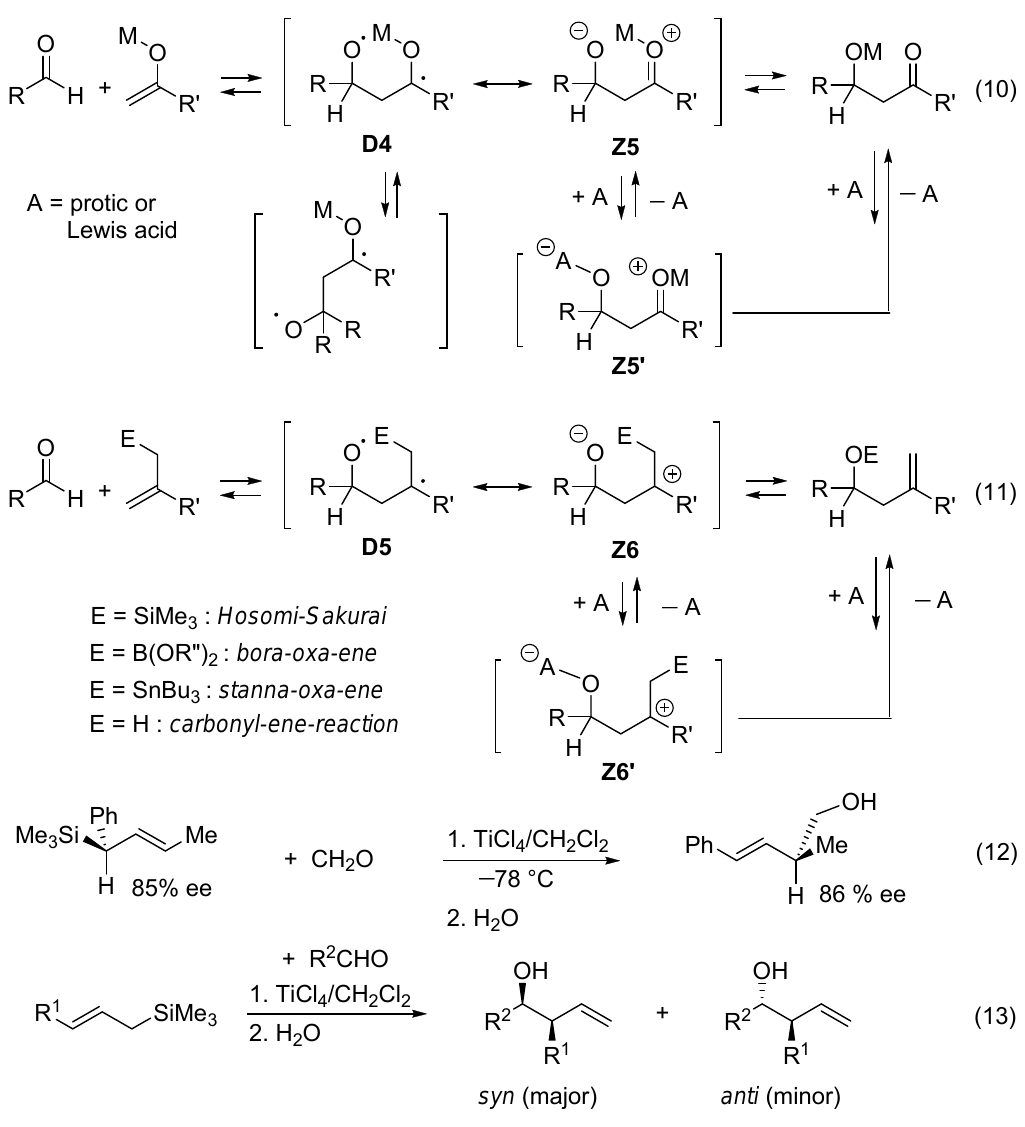
Figure 6. The diradicaloid model illustrated with Equilibria (10) and (11) permits to explain the catalytic effect of added protic or Lewis acids (A) to enolate aldol condensations, to metalla-carbonyl-ene reactions, and the carbonyl-ene-reaction.